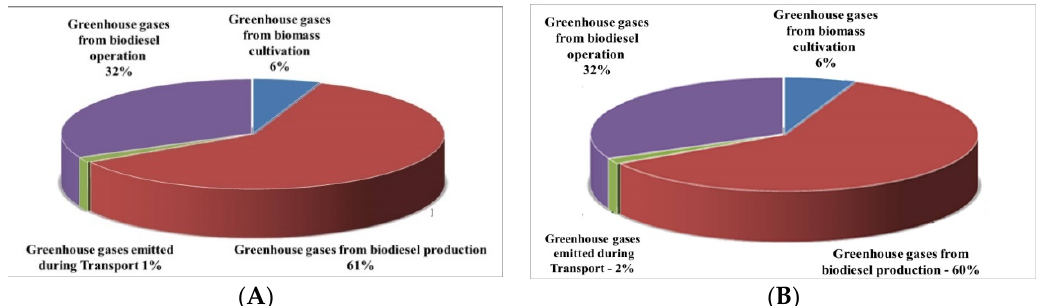
Figure 5. ( A ) Minimum total GHG emissions. ( B ) Minimum total annual costs. Distribution of total GHG emissions for the life cycle stages of biodiesel for the period 2016-2020.